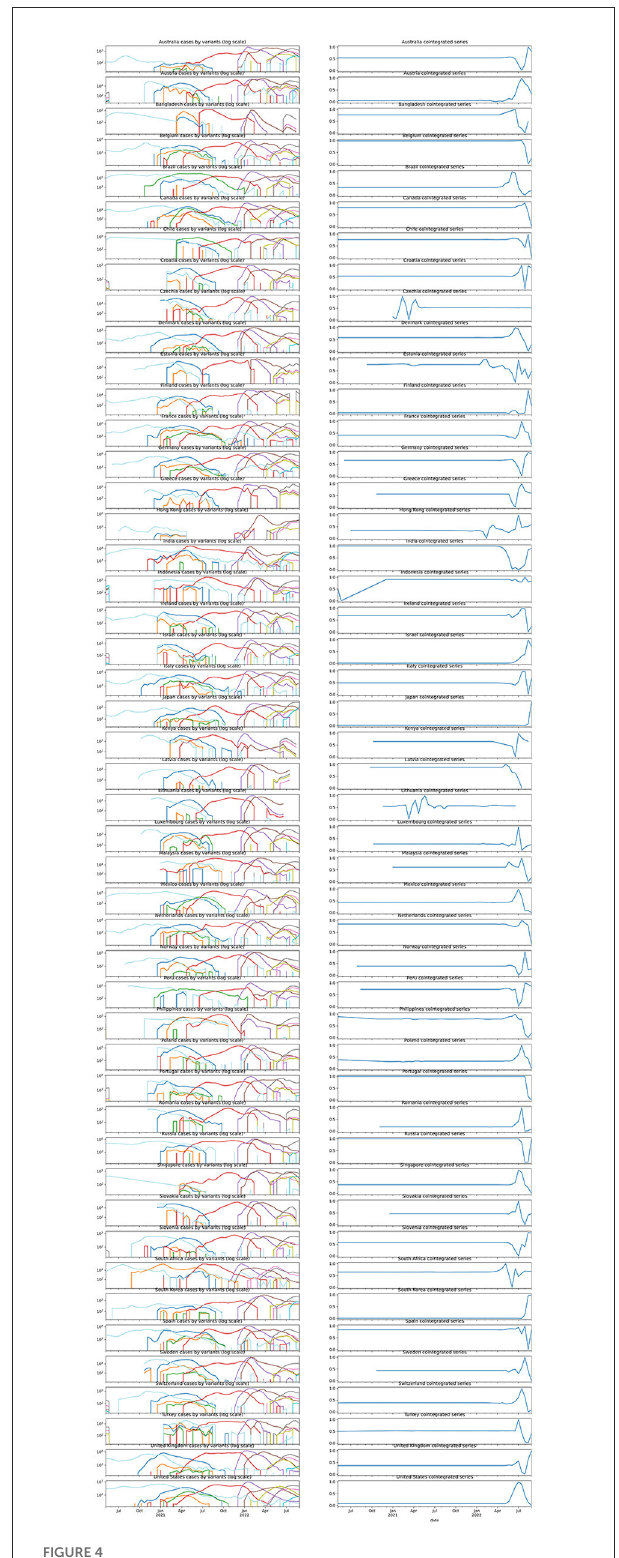
FIGURE4 Case-by-variant by country and their corresponding normalized cointegration